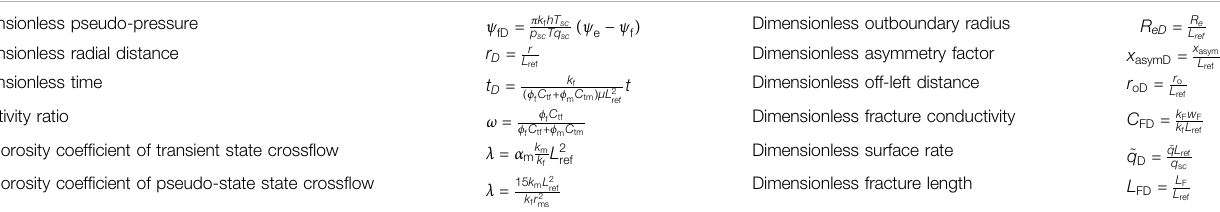
TABLE 1 | dimensionless variable de fi nition.